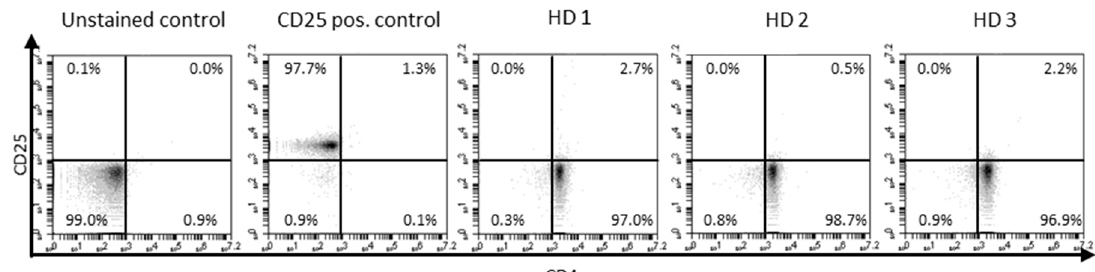
Figure A6. Flow cytometric analysis of T cell purity. CD4 + CD25 − cells showed a purity of around 98% after isolation. CD4 + CD25 − T cells were isolated as described in the manuscript. Shown are the unstained control, the CD25-positive staining control, and successful CD4 + CD25 − isolations of three different healthy donors.